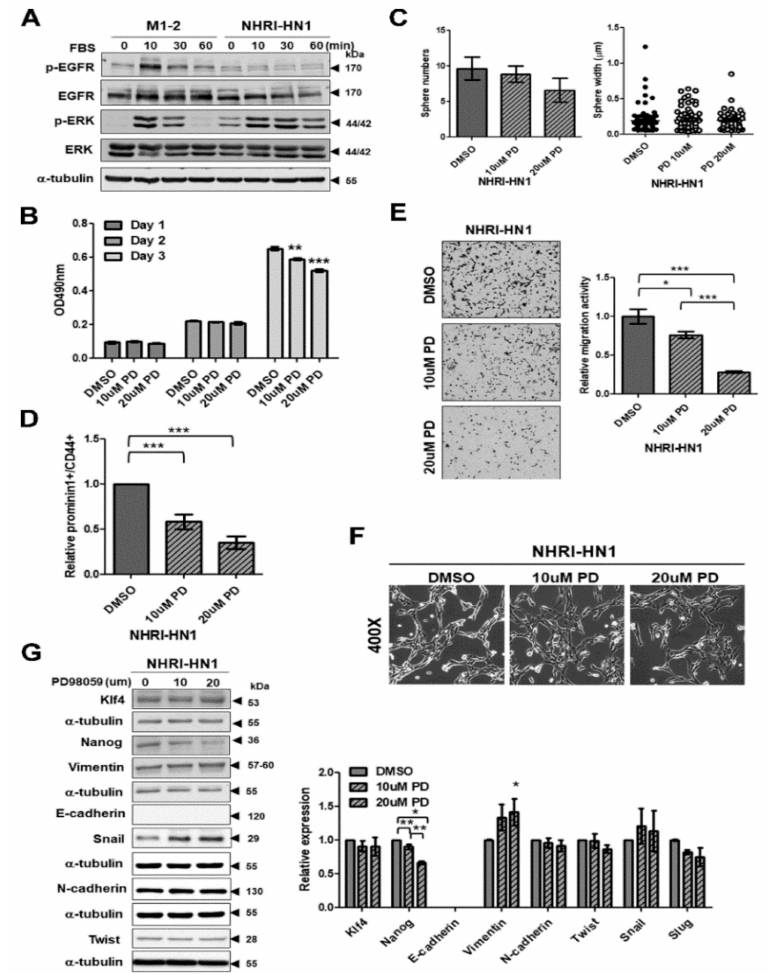
Figure 6. Inhibition of extracellular signal-regulated kinase (ERK) activation decreased cell migration and stemness in NHRI-HN1 cells. ( A ) Time course immunoblot assay for total and phosphorylated EGFR, ERK and AKT in M1-2 and NHRI-HN1 cells after 10, 30, and 60 min of fetal bovine serum